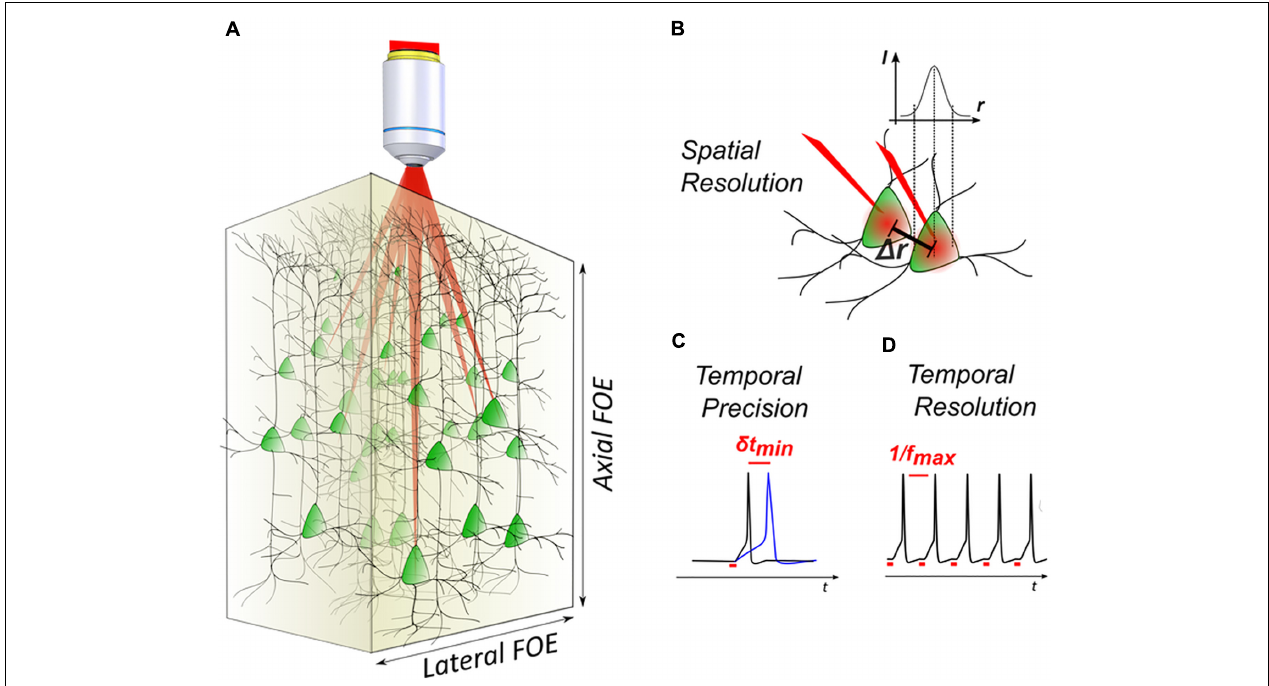
FIGURE 1 | 3D light-targeted photostimulation. (A) SLM-based multiplexing strategies allow to target opsin-expressing neurons over axial and lateral fields of excitation, extending over a few hundred microns in the brain. (B) The photostimulation resolution defines the minimal distance (cid:49) r between two targets, at which each target can be individually activated. (C) Photostimulation temporal performances are linked to the photostimulation temporal precision, that is the timing precision δ t in evoking action potentials (APs) with repetitive stimulations (i.e., light-evoked spike jitter) and (D) the temporal resolution, that is the minimal time interval between two consecutive light-evoked APs (i.e., the maximum light-driven neuronal firing rate f max